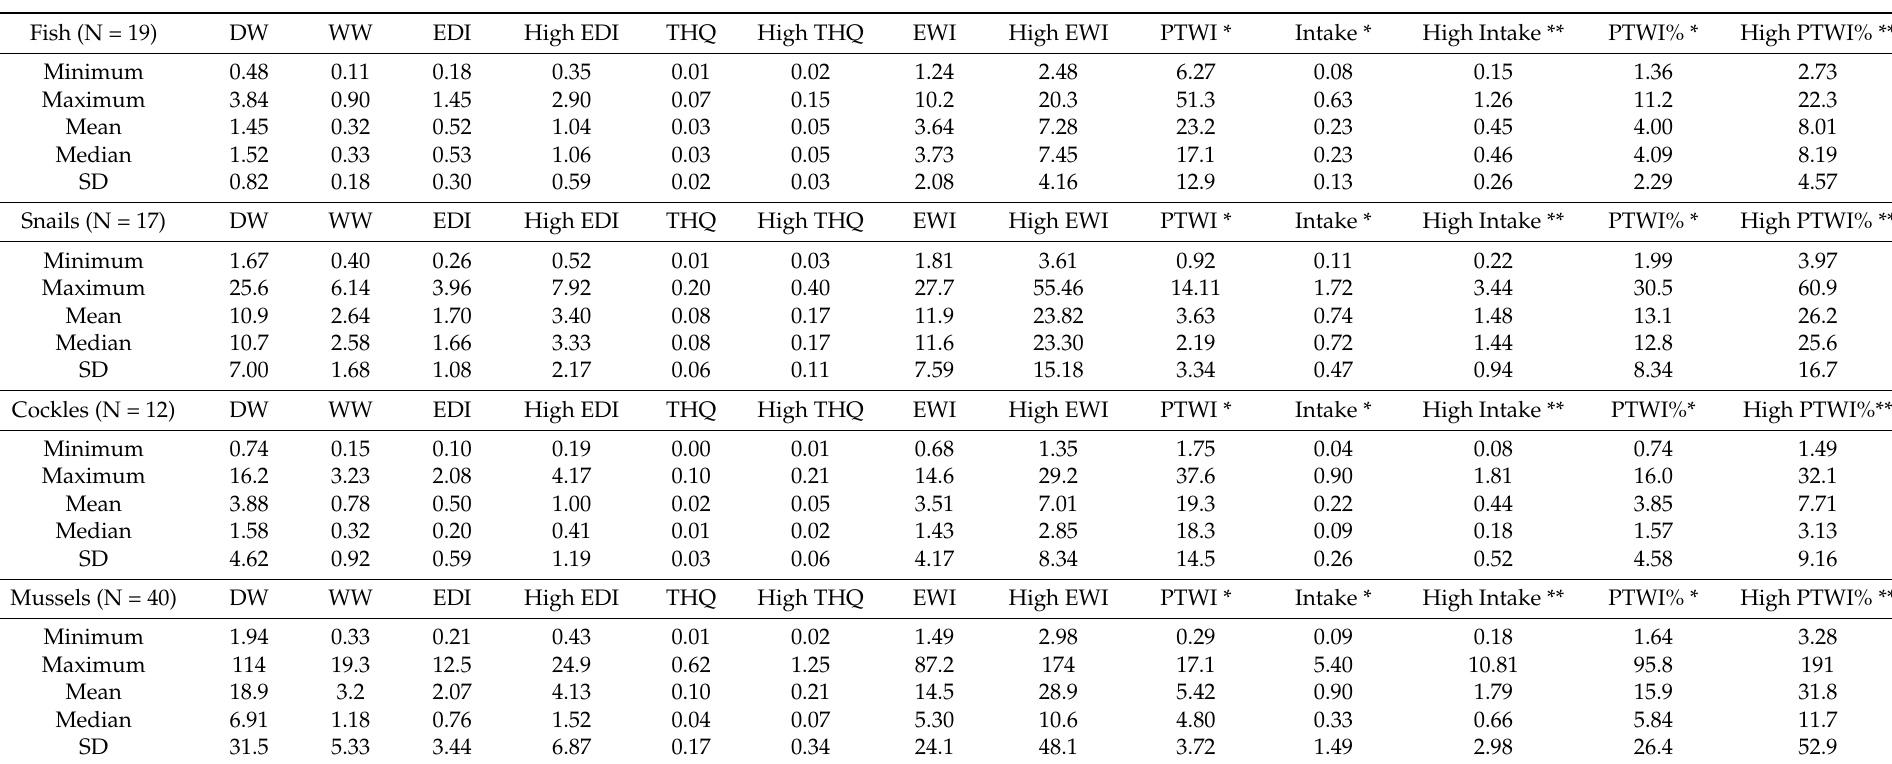
Table 1. Comparison of overall statistics of the values of nickel concentrations (mg/kg in dry weight (DW) and wet weight (WW)), estimated daily intake